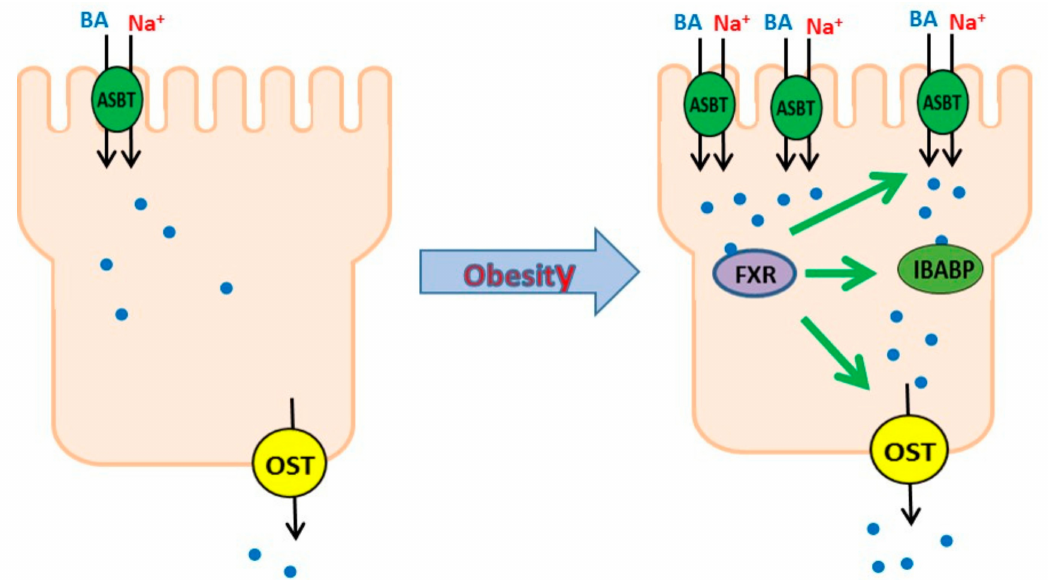
Figure 9. E ff ect of obesity on bile acid cotransport in intestinal villus cells. Obesity stimulates ASBT and other bile-acid-handling proteins likely via the stimulation of FXR in intestinal villus